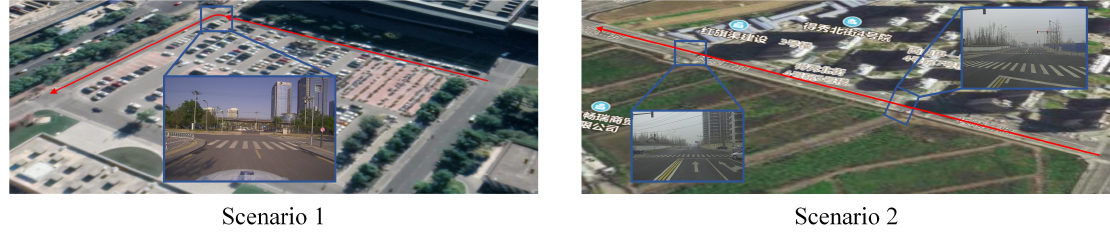
Figure 12. The experimental scenarios.